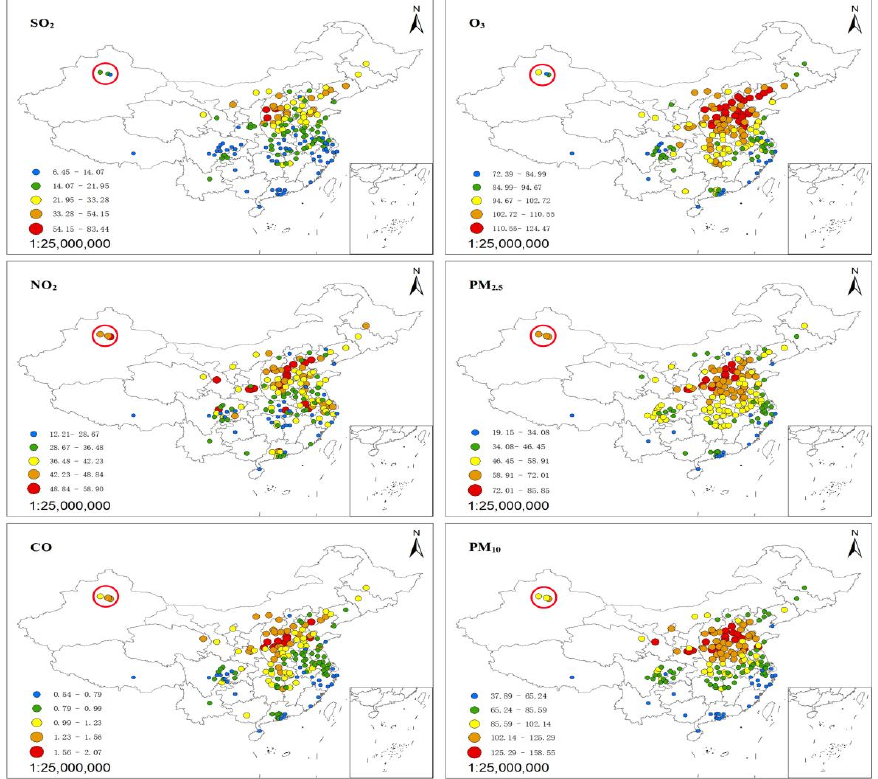
Figure 8. Comparison of annual average concentrations of six air pollutants in 168 major cities in 2017 ( μ g m − 3 ). The red circles represent the Wu-Chang-Shi urban. Nationally, pollution is more severe in cities in north-central China and less severe in cities in southern China [24]. The main pollutants commonly found in China are PM 2.5 , followed by PM 10 and O 3 [39]. The annual average concentrations of PM 10 (67.29 μ g m − 3 , 61.87 μ g m − 3 , 70.31 μ g m − 3 ) and PM 2.5 (98.49 μ g m − 3 , 102.14 μ g m − 3 , 115.05 μ g m − 3 ) in Changji, Shihezi, and Urumqi were higher, but in moderate pollution. 91. 07% and 81.55% of the cities for PM 2.5 and PM 10 exceeded the CAAQS secondary standard, respectively.